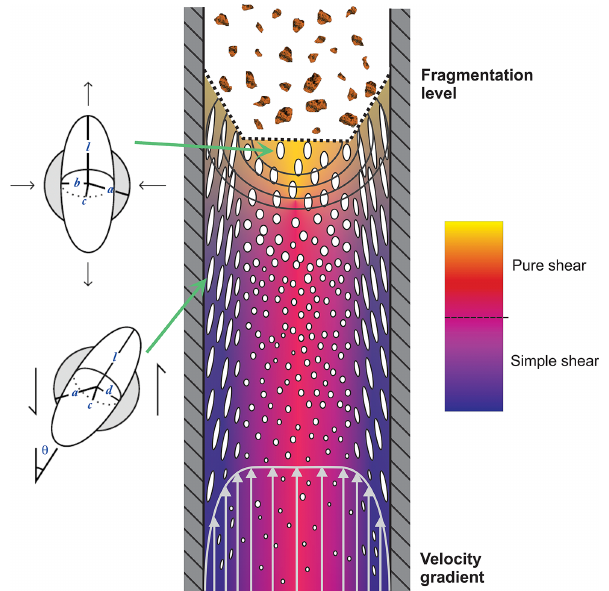
Figure 1. Eruptive shearing. Schematic view of magma shear- ing during eruptions. Strain localization along the conduit margins promotes a heterogeneous velocity gradient, which induces sim- ple shearing (blue) and stretching of bubbles (white ellipses). In the core of the magma column, a relatively low-velocity gradient leaves the bubbles mostly undisturbed and near isotropic. Relatively rapid decompression increases bubble pressure, which, if exceed- ing the magmastatic pressure, will force the bubbles into a tensional regime, which may promote pure shear. The deformed bubble shape can be characterized by the semi-principle axes of a best-fit ellipsoid l , b , and c (modified from Rust et al., 2003).